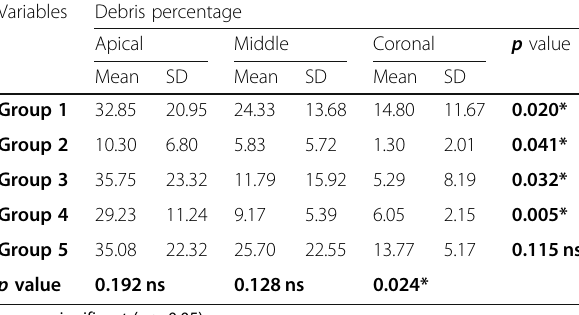
Table 2 The mean and standard deviation (SD) of debris percentage in each third in different groups Variables